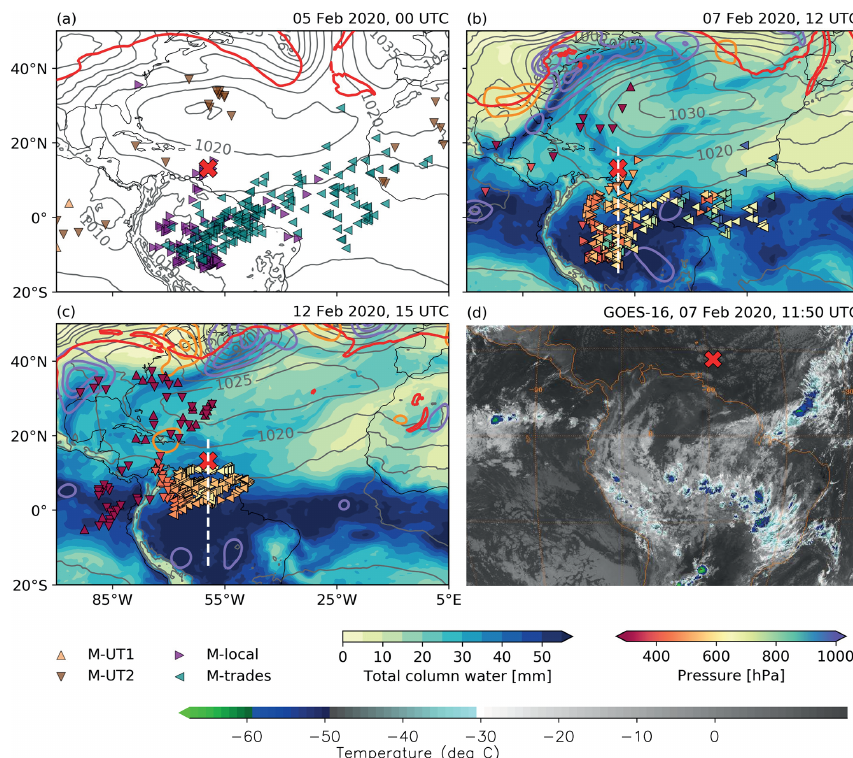
Figure 14. Synoptic situation over the North Atlantic and the position of backward trajectories from the BCO started in the layer 650– 300hPa on 14 February 2020 (00:00–21:00UTC, every 3h) at (a) 00:00UTC on 5 February, (b) 12:00UTC on 7 February, (c) 15:00UTC on 12 February 2020, and (d) cloud top temperature detected by the infrared channel (10 . 2–11 . 6µm) of the GOES-16 satellite at 11:50UTC on 7 February 2020 (note the different projection). Trajectory positions are shown as triangles colored according to the (a) airstream or (b, c) pressure. Color shading shows total column water, and contours show sea level pressure (gray; 5hPa intervals), upward and downward winds at 500hPa (purple and orange, respectively; ± 0.2, ± 0.4, ± 0.6Pas − 1 ), and 2pvu at 320K (red). The red cross marks the location of Barbados and the dashed white line the location of the cross section shown in Fig. 16. A Gaussian filter was applied to the vertical winds for better readability. Data: (a–c) ERA5 and (d)